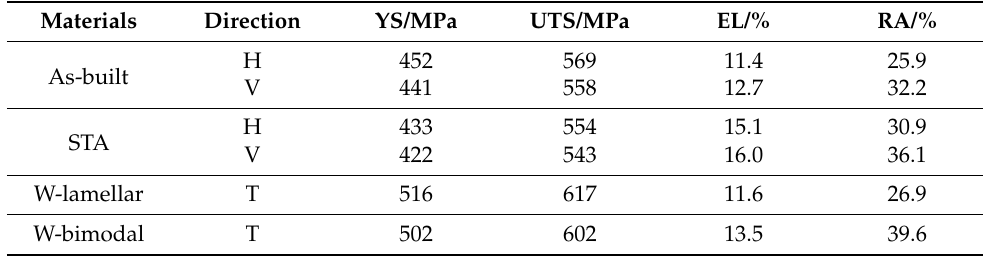
Table 4. Tensile properties for the EB-DED and wrought Ti60 alloy at 600 ◦